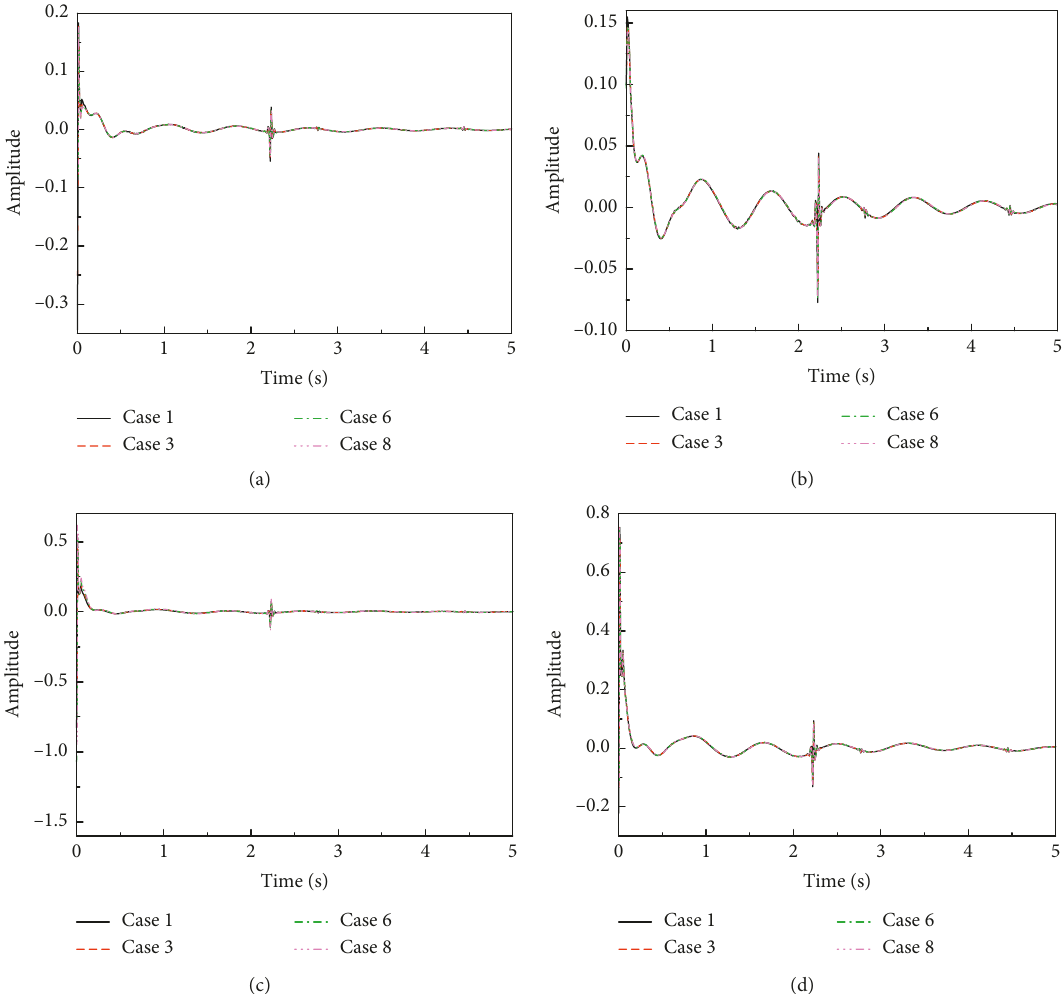
Figure 7: Virtual impulse response functions of reference point and measuring points in model tests (single damage). (a) Point 1. (b) Point 7. (c) Point 12. (d) Point